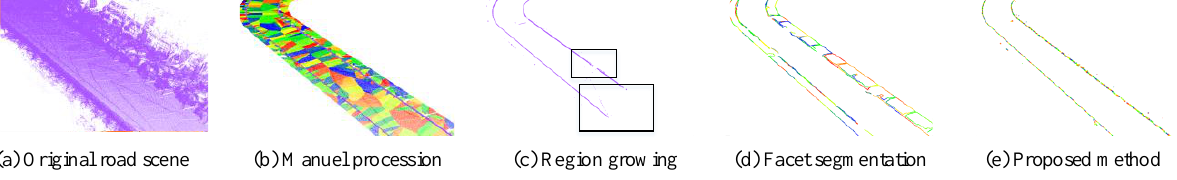
Figure 6. Visual comparison of three contour extraction methods for Road 1 (the brick-red color points are ground-truth points).